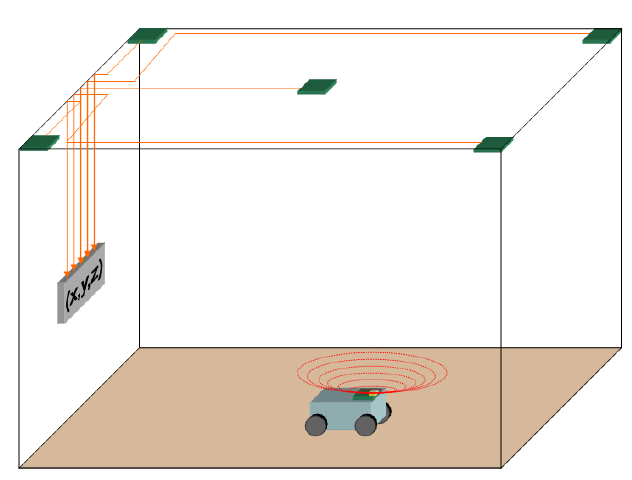
Figure 2. Basic locating